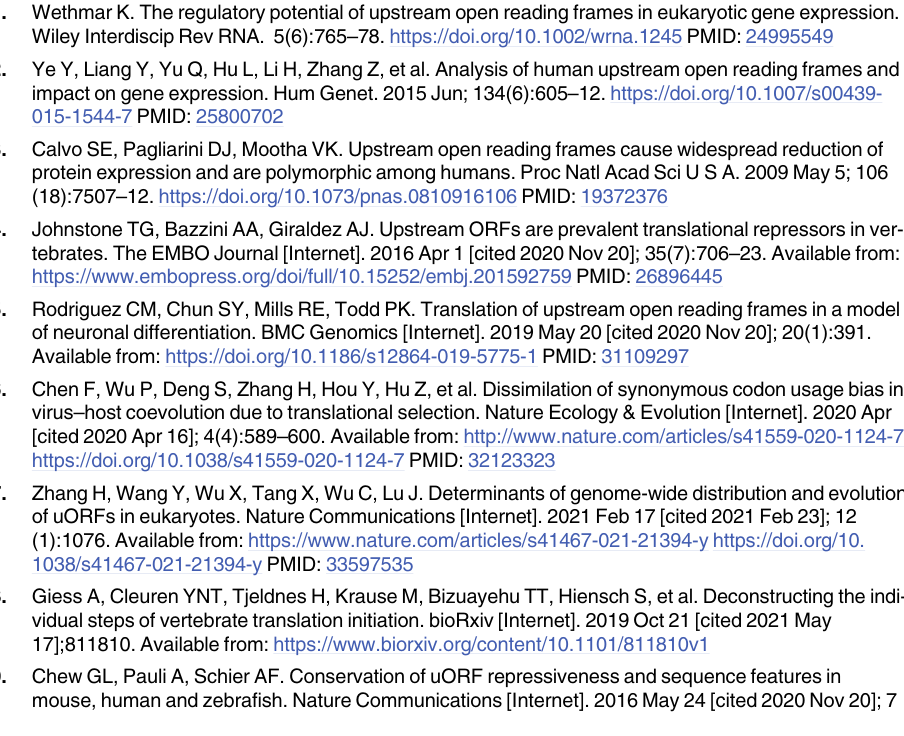
S1 Table. List of plasmids used in this study.